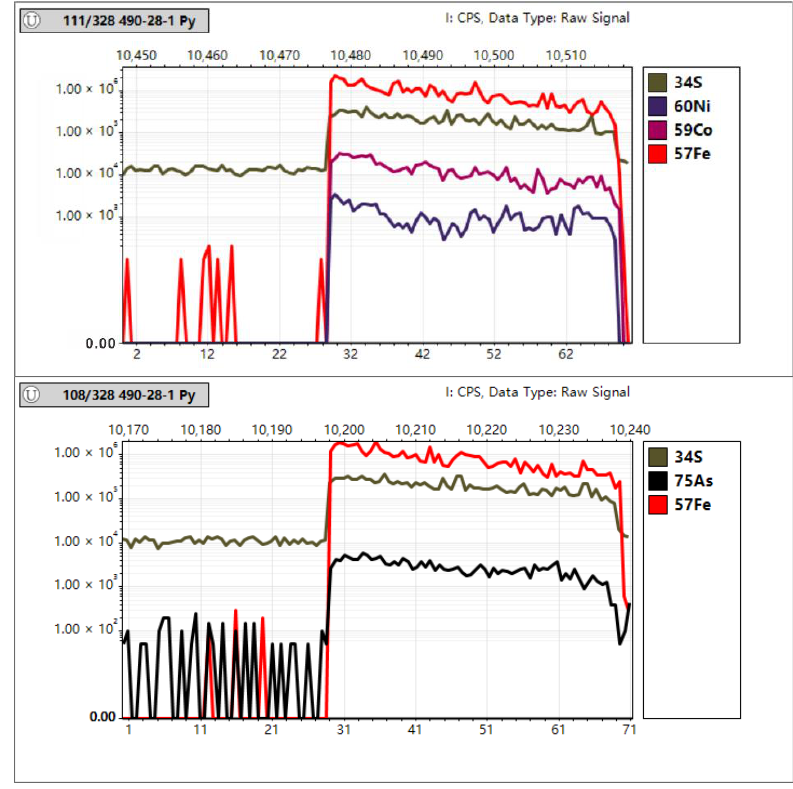
Figure 6. Time-resolved depth profiles of Co, Ni and As in Sample 490-28.